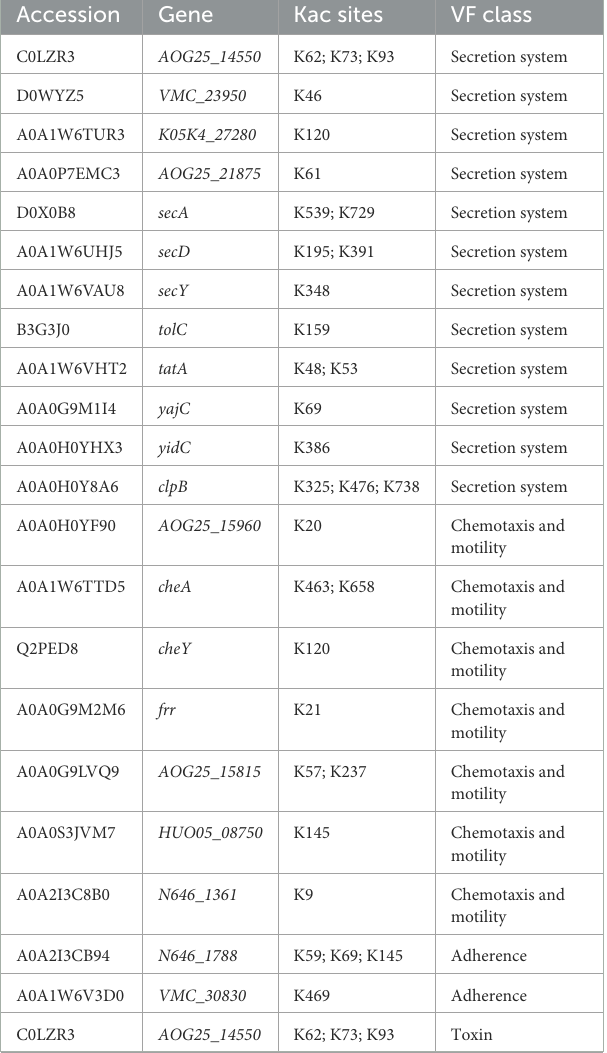
TABLE 1 Virulence factors in V. alginolyticus under bile salt